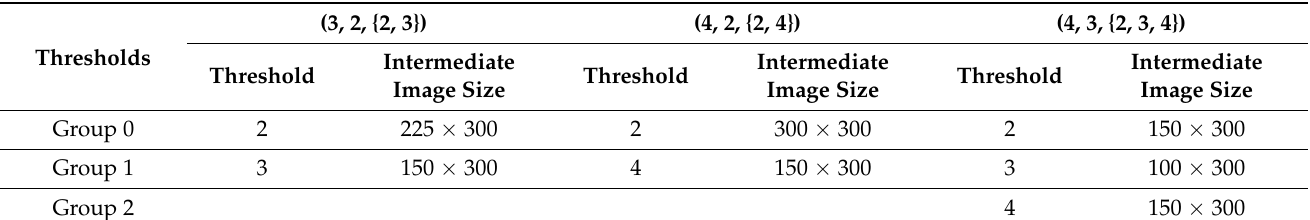
Table 1. Sizes of shared images in the proposed secret image partition strategy ( SIPS